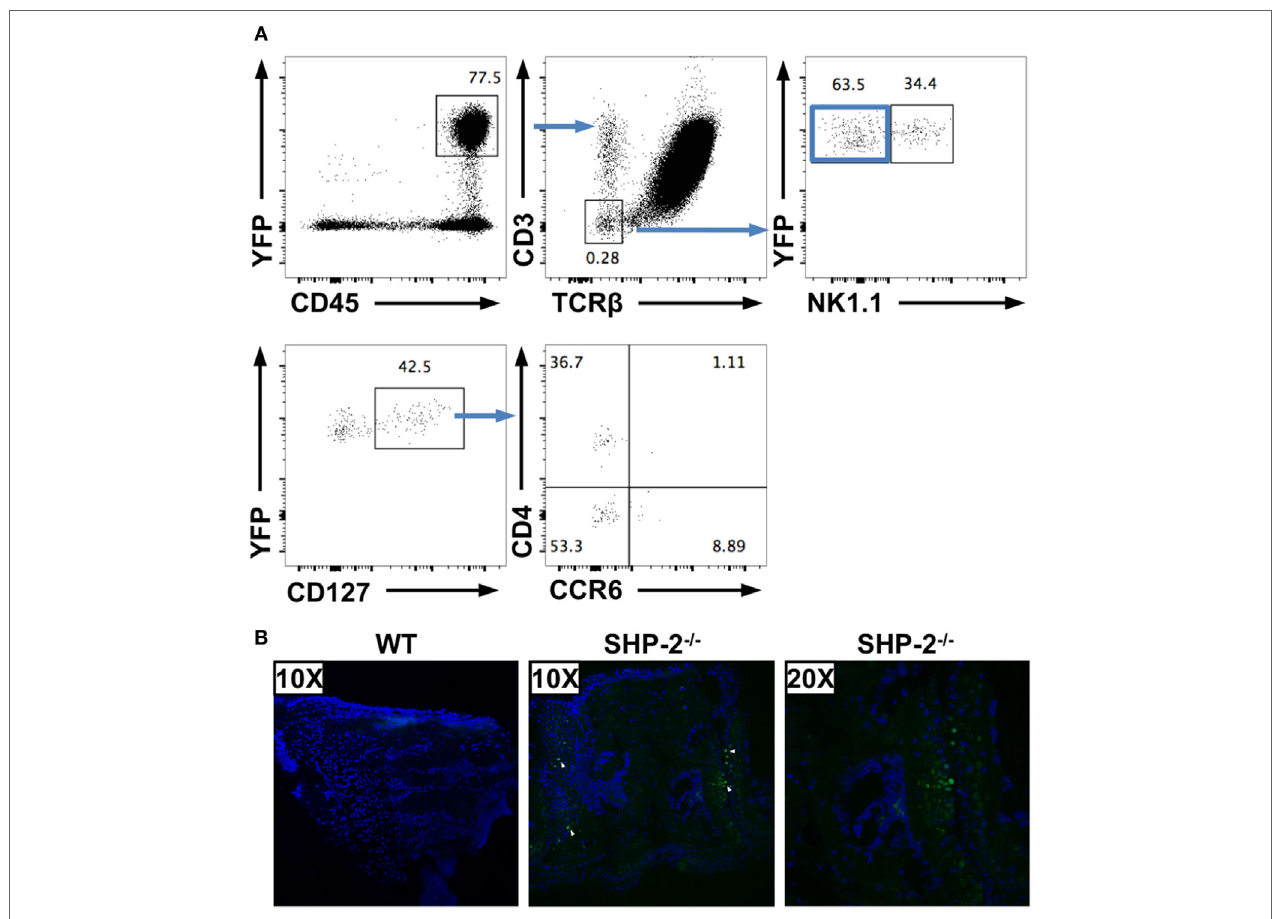
FigUre 5 | Several non-T cell subsets have an history of CD4 expression. (a) CD19 − YFP + splenocytes were gated for non-T cells (CD3 − TCR β − ) and separated in NK1.1 − and NK1.1 + cells. CD127 + cells from NK1.1 − cells were subdivided based on CD4 and CCR6 expression. (B) 30 µm serial sections of frozen wrist tissues were prepared from SHP-2 ± CD4-Cre-RosaYFP and SHP-2 − / − CD4-CreRosaYFP mice and imaged on a Nikon C1SI confocal microscope. Nuclei indicated by DAPI staining (blue) and YFP detected in GFP channel (green, white